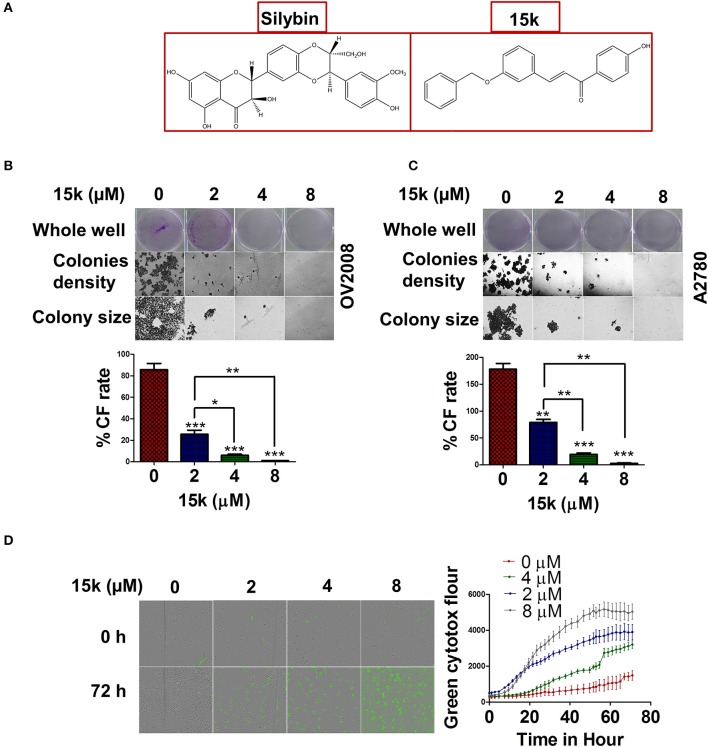
15k effect on colony formation rate and viability of ovarian cancer cells (A) The chemical structures of silybin A and 15k (B,C) Representative images of the whole well, the densities of the colonies formed (10x) and the colony size (20x) of OV2008 and A2780, respectively, after incubation with 15k (0, 2, 4, and 8 μM). The colony formation rate (%CF rate) is shown under each cell type in the graph. The results are presented as the means ± SD of three independent experiments. *p < 0.05, **p < 0.01, ***p < 0.001. (D) The real time green cytotox fluorescent reagent (IncuCyte) indicating the number of dead OV2008 cells over time after incubation with 15k (0, 2, 4, and 8 μM). The data are presented as images showing the fluorescence level at the 0 and 72 h time points. In addition, a detailed time curve quantitatively summarizing the results at each time point is shown where fluor is for fluorescence. The data are presented as the means ± SEM of three independent studies.